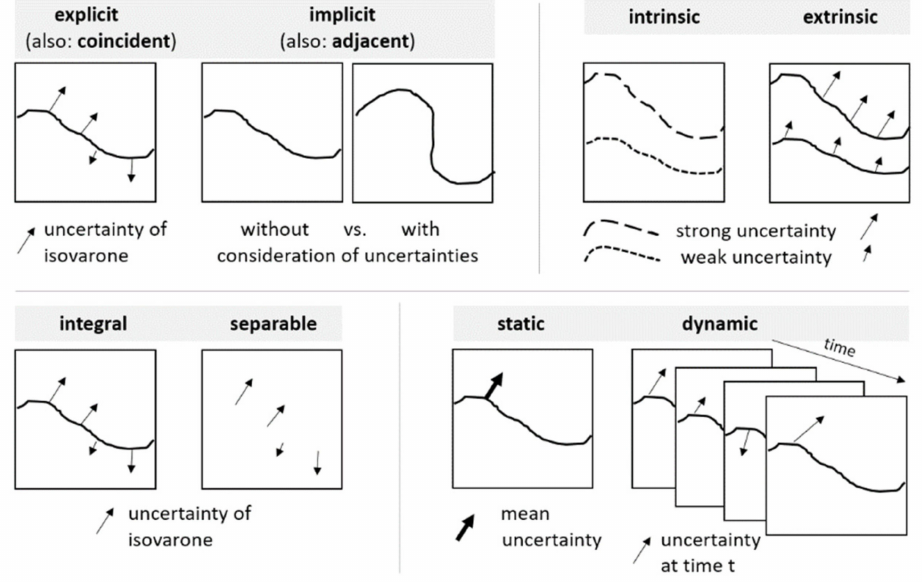
Figure 3. Dichotomous categories of uncertainty